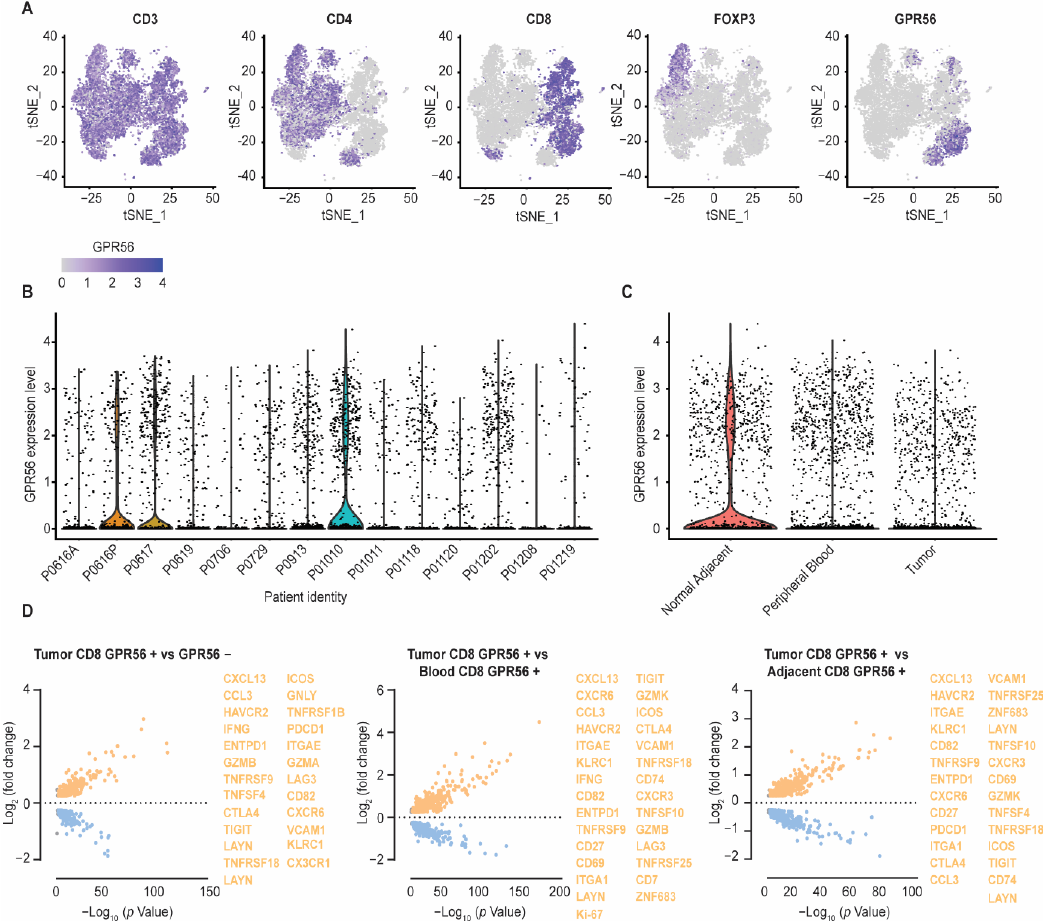
Figure 2. Compared to blood and adjacent tissue, tumor localized GPR56-positive CD8 T cells dis- play a distinct gene expression profile with upregulated tumor-reactive markers. ( A ) GPR56 expres- sion visualized within the CD3, CD4, CD8 and FOXP3-expresssing cell subsets by dimensional re- duction analysis (t-SNE) using a single- cell RNA sequencing data set, consisting of 12,346 T cell samples isolated from the blood, healthy adjacent tissue and tumor tissue of 14 treatment-naïve non- small-cell lung cancer (NSCLC) patients. ( B ) Inter-patient GPR56 expression variability. ( C ) GPR56 expressing cells subdivided into their anatomical isolation sites (blood, healthy adjacent tissue and tumor tissue). ( D ) Differential gene expression of the GPR56-positive vs. GPR56-negative popula- tion within the CD8 T cell fraction isolated from tumor tissue (left) and differential gene expression of the GPR56-positive CD8 T cell fraction isolated from the tumor tissue vs. the GPR56-positive CD8 T cell fraction isolated from the blood (middle) and the healthy adjacent tissue (right). DEGs were calculated using FindMarkers function from Seurat with MAST as the method of choice. Genes with a p - value ≤ 0.05 and log2FoldChange ≥ 0.25 are displayed, visualized in volcano plots using lighted in orange.